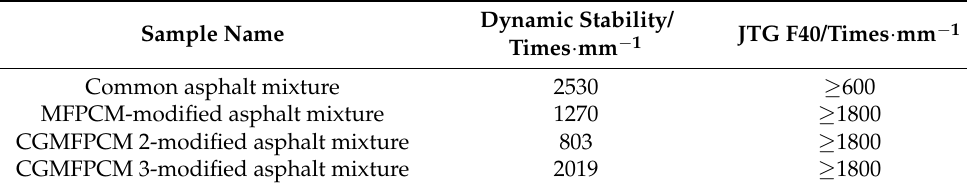
Table 14. Wheel tracking test results for common and modified asphalt mixtures.